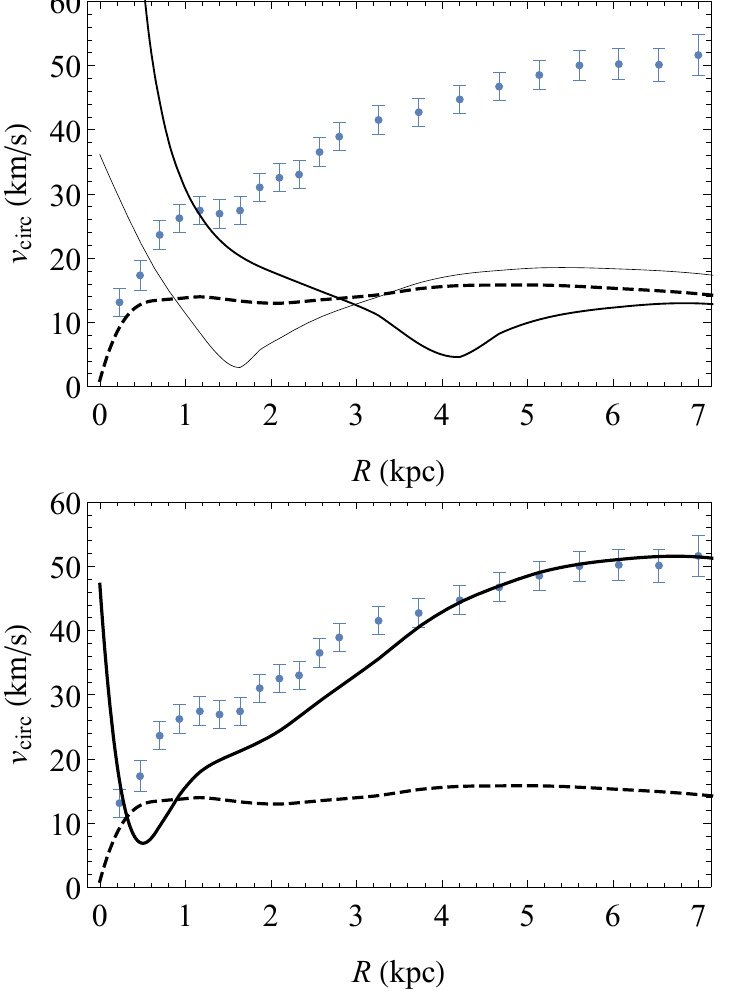
Figure 6 . Comparison of the data points of NGC3741 with the n = 3 rotation curve of the theory T v with weighted derivatives in the limit of weak fractional corrections with a data-based matter density profile for α = 1 (Einstein’s theory, dashed curve), α = 1 . 1 , 1 . 6 and R = 5 kpc (top panel, ∗ increasing thickness) or α = 4 / 3 and R = 0 . 7 kpc (bottom ∗